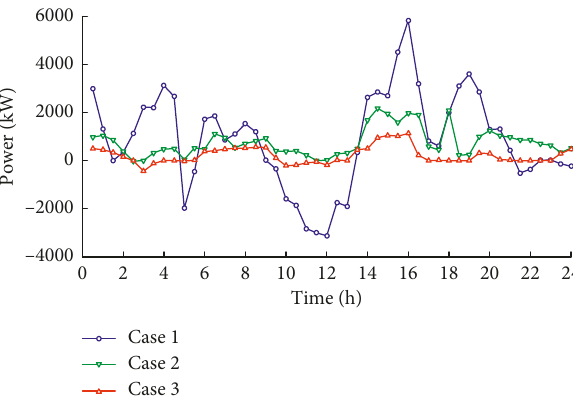
Figure 4: The net load of the Energy Internet under three